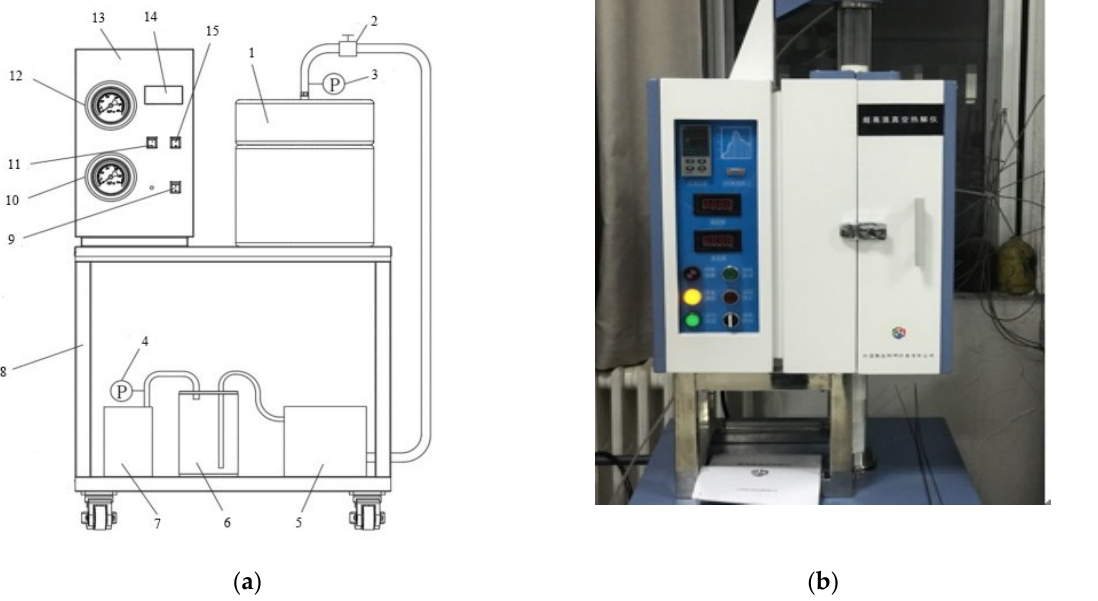
Figure 2. The particularly designed stepwise multi-temperature anaerobic heating equipment. ( a ) Schematic diagram of the equipment. 1—pyrolysis chamber, 2—exhaust valve, 3—the first pressure sensor, 4—the second pressure sensor, 5—condenser, 6—collecting tube, 7—suction filter pump, 8—supporting platform, 9—main power switch, 10—suction pressure indicator, 11—heating switch, 12—pressure indicator in the kettle, 13—power control box, 14—temperature control meter, 15—pumping switch. ( b ) The real developed equipment.